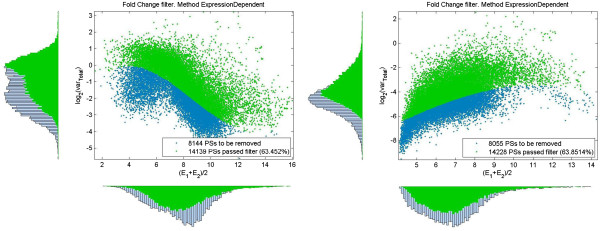
Application of an expression dependent threshold (14). Scatterplot of features in the two-dimensional space of log2(variance), average expression for two different pre-processing methods: MAS5 – left panel and RMA – right panel. Data from data set GSE6011 (see Table
1) consisting of 37 samples. Blue dot represent features satisfying condition (11) and therefore considered as coming from null distribution. Green points represent features having total variance above expression dependent threshold and considered as non-nulls. On each panel, marginalized distributions of all and non-null features over variance is shown on the left side and marginalized distribution of all and non-null features over average expression is shown at the bottom of the panel.